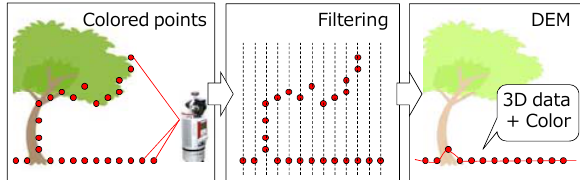
Figure 5. DEM generation from terrestrial LiDAR data